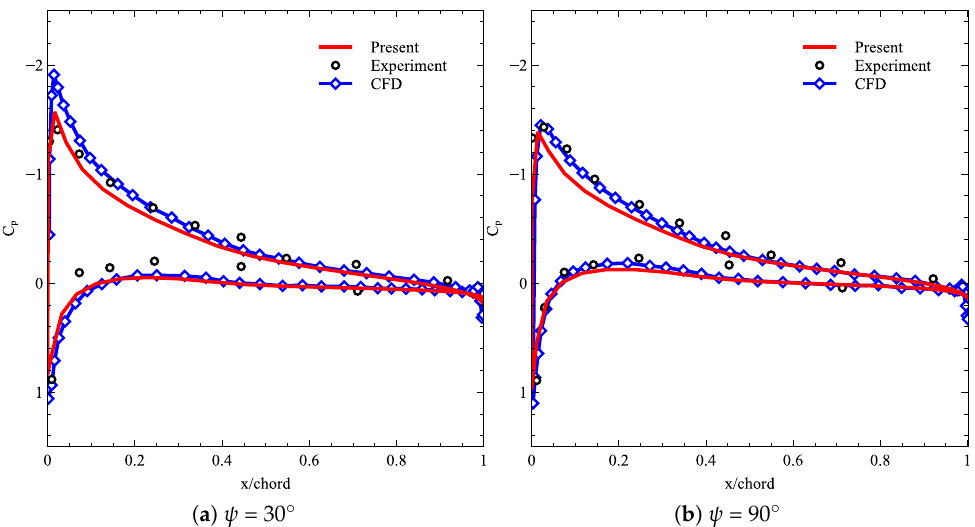
Figure 10. Pressure coefficient at r/R =